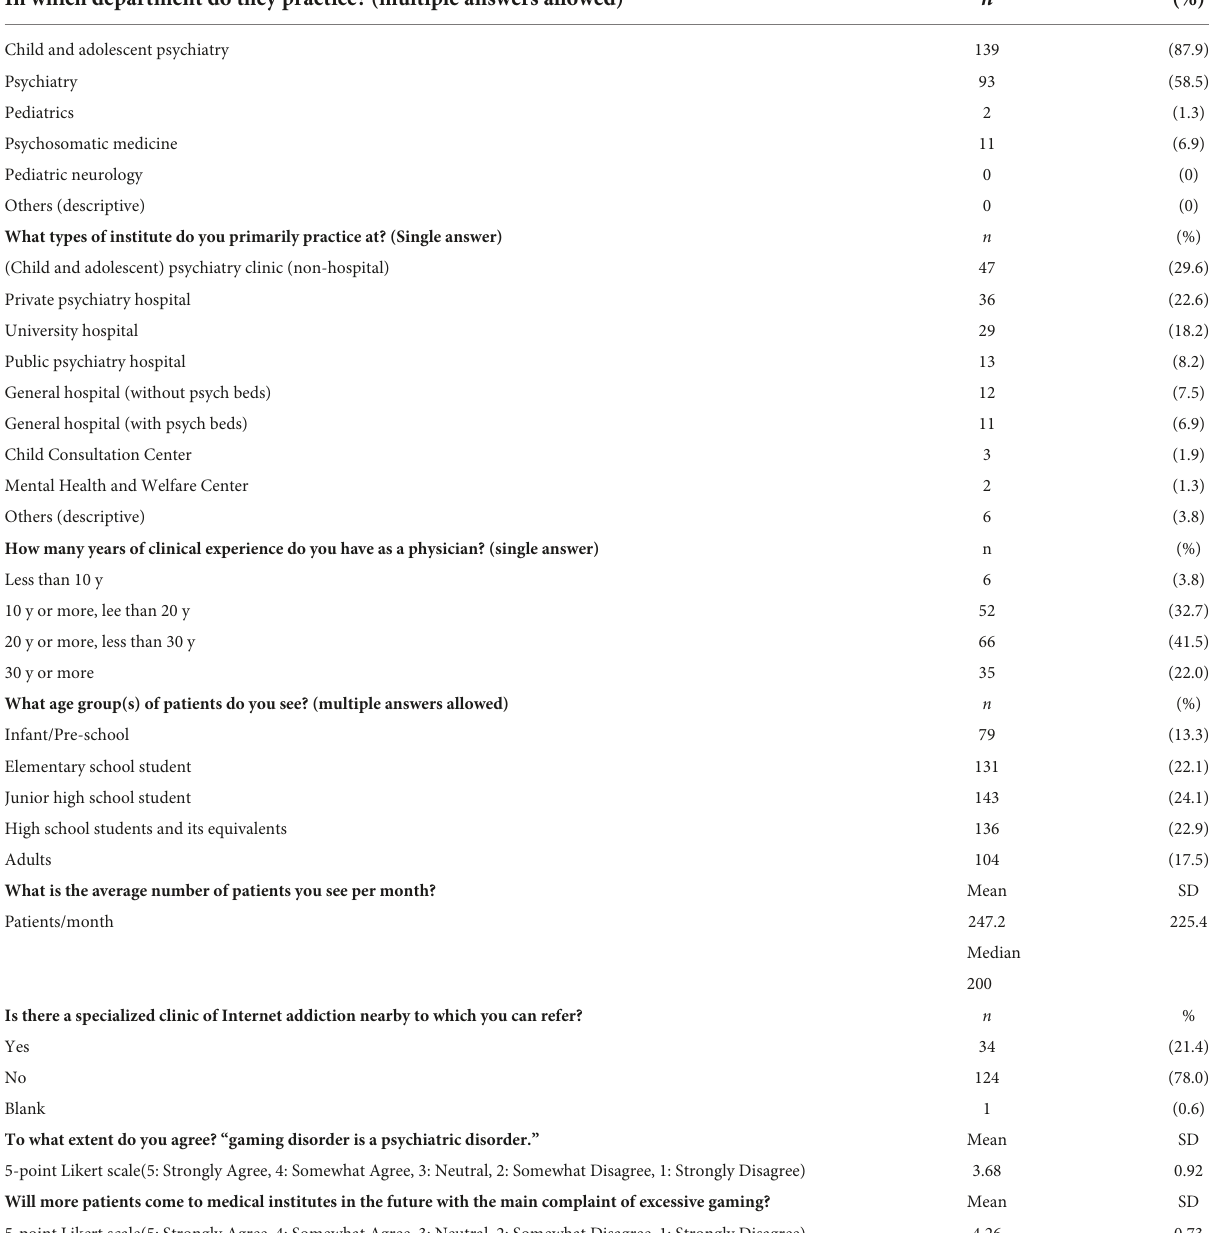
TABLE 1 Sociodemographic and attitude toward gaming disorder of respondents ( n =